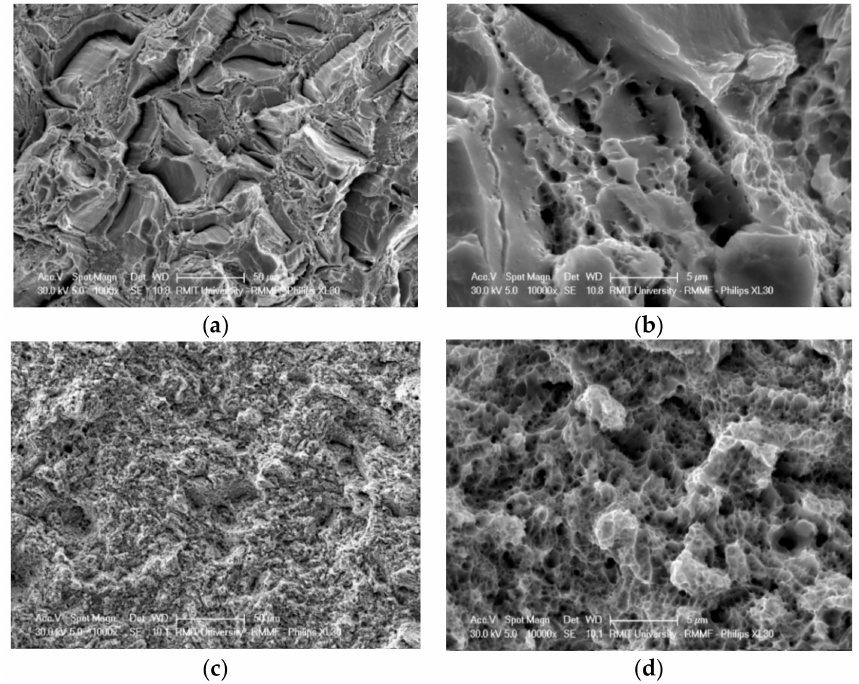
Figure 7. Fracture surfaces of tensile test specimens: ( a , b ) As-built and ( c , d ) heat treated 1000 ◦ C / 5